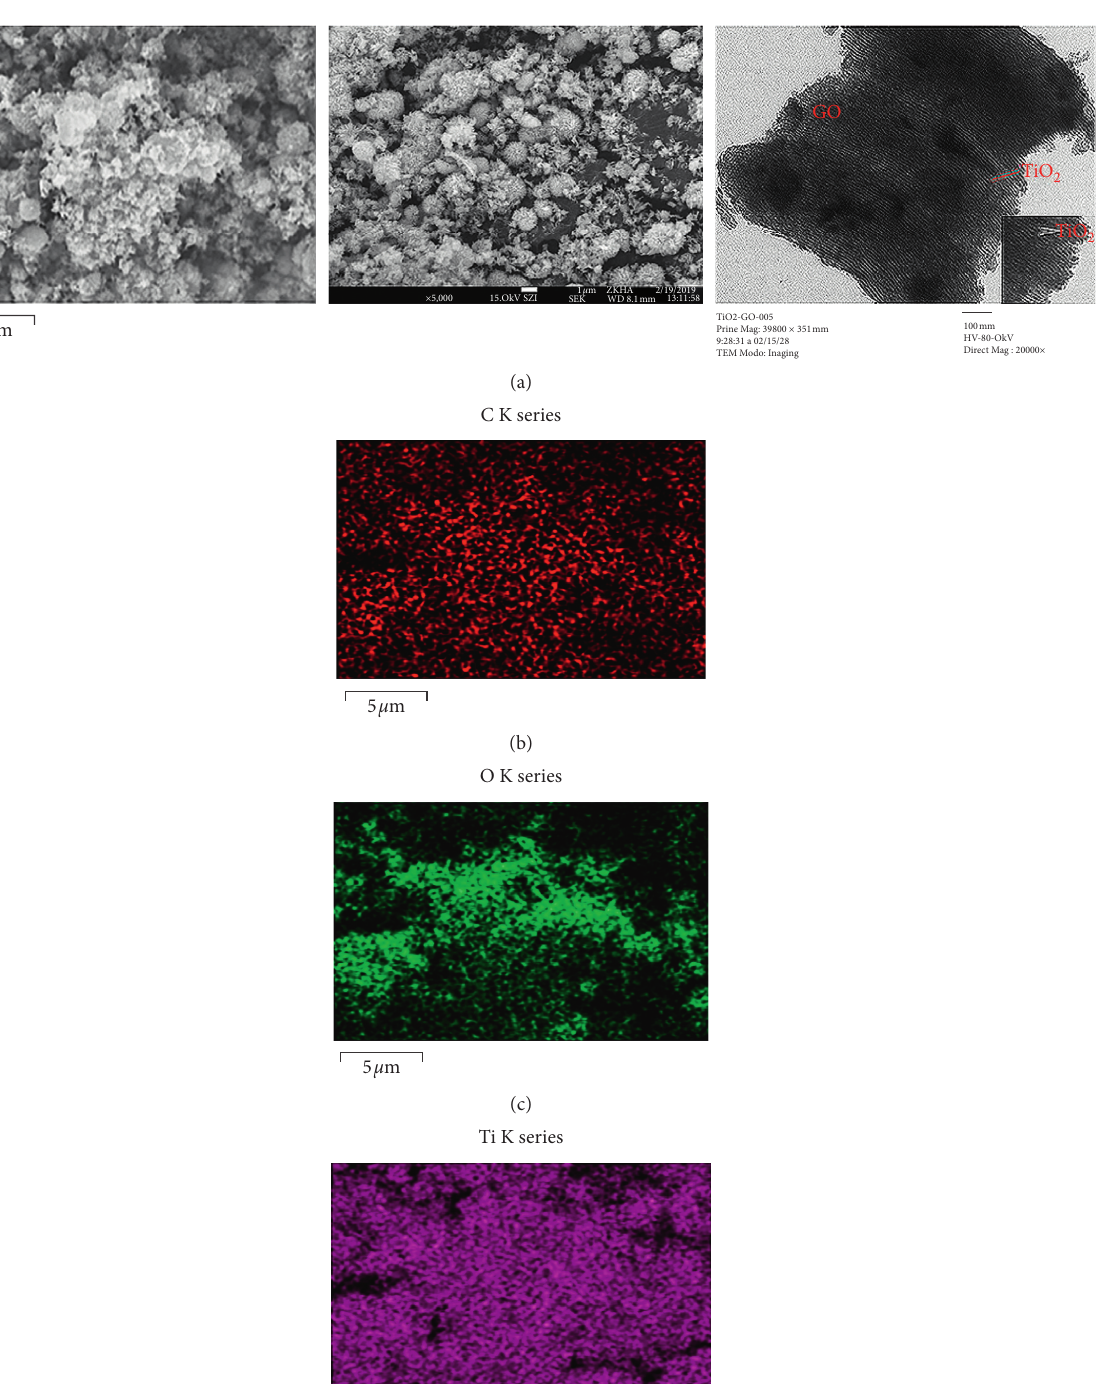
Figure 1: SEM (a1, a2), TEM (a3), and EDX mapping images of C (b), O (c), and Ti (d) elements of GO-TiO